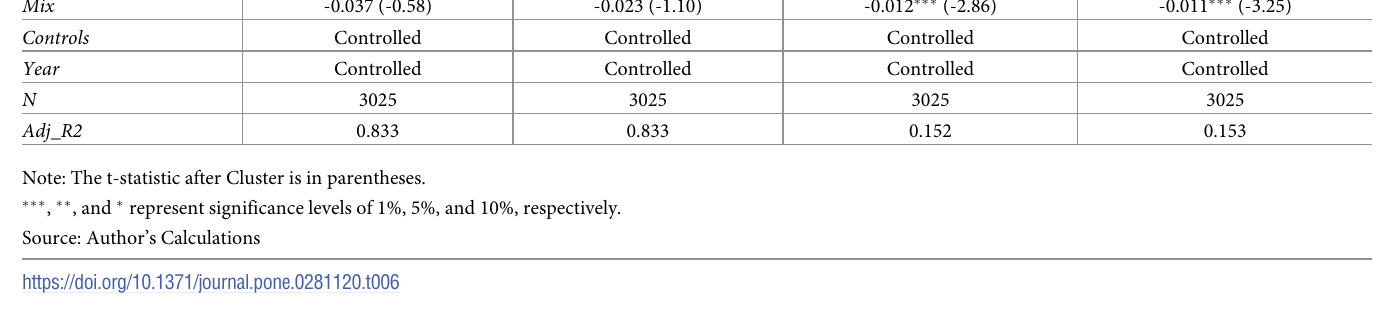
4.2.1 The role of the level of government control. Table 7 is the regression results of the model (3), which reports the impact of mixed ownership reform at different levels of govern- ment control on the speed of capital structure adjustment. Columns (1) and (2) shows the coefficients of the interactive items ( Mix × Laglev ) of the directors of the board appointed by the non-state-owned shareholders ( Mix _ d ) and the capital structure in the firm last year ( Laglev ), and the interactive items of the directors, supervisors and top executives appointed by non-state-owned shareholders ( Mix _ djg ) and Laglev in central state-owned enterprises (CSOEs) are negative, but both are not significant. However, these two coefficients in local state-owned enterprises (LSOEs) are negatively significant at 5% level (and the sample coeffi- cients difference of groups of monopolistic state-owned enterprises and competitive state- owned enterprises are respectively significant at the 5% level), indicating that the top executive appointment of non-state-owned shareholders in LSOEs accelerate the adjustment of capital structure, compared to that in CSOEs. This is consistent with our hypothesis 3. Table 8 is the regression results of the model (4), which reports the impact of mixed owner- ship reform of state-owned enterprises at different levels of government control on the devia- tion of the capital structure. Column (1) and column (2) present that the coefficients of Mix _ d and Mix _ djg in CSOEs are all negative, but not significant, while those in LSOEs in column (3) and column (4) are negatively significant at the 5% level (and the sample coefficients difference